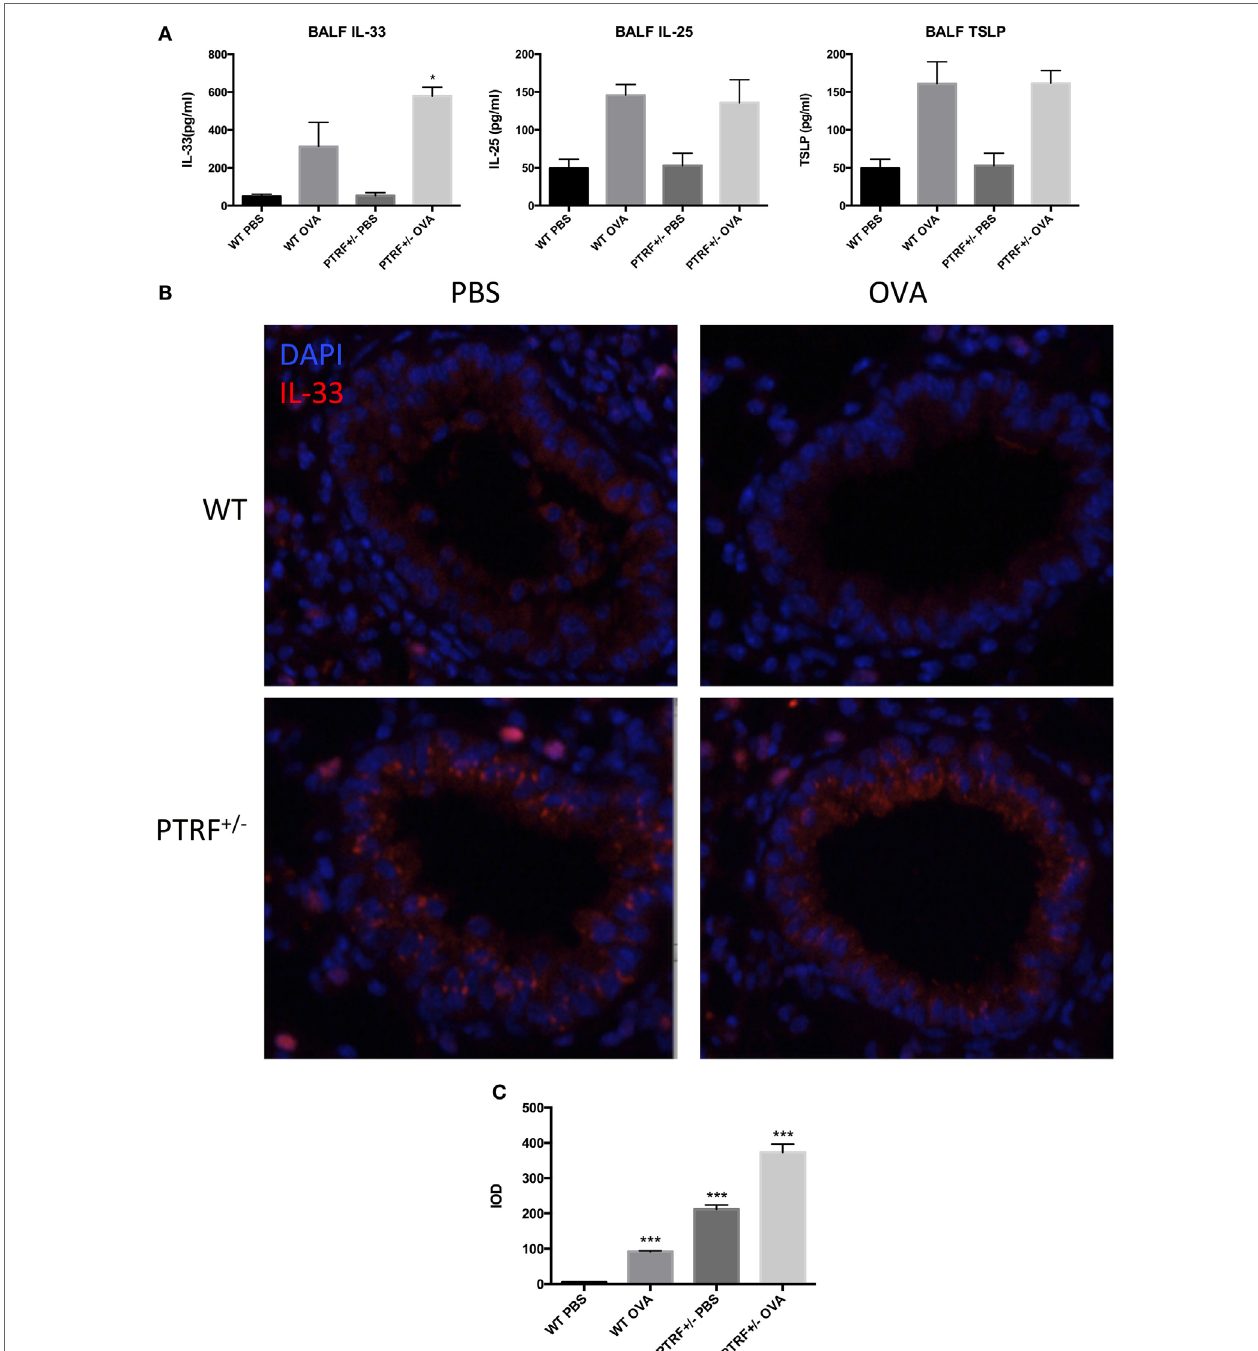
FigUre 3 | IL-33 release in airway. (a) IL-33, IL-25, and TSLP levels in bronchoalveolar lavage fluid. (B) Representative images of IL-33 (red) immunofluorescence of airway. (c) Integrated option density (IOD) of IL-33 (red) immunofluorescence images. * p < 0.05, *** p < 0.001, as determined by Student’s t -test. Results are pooled data from four independent experiments (mean ± SEM of n = 4 mice in each